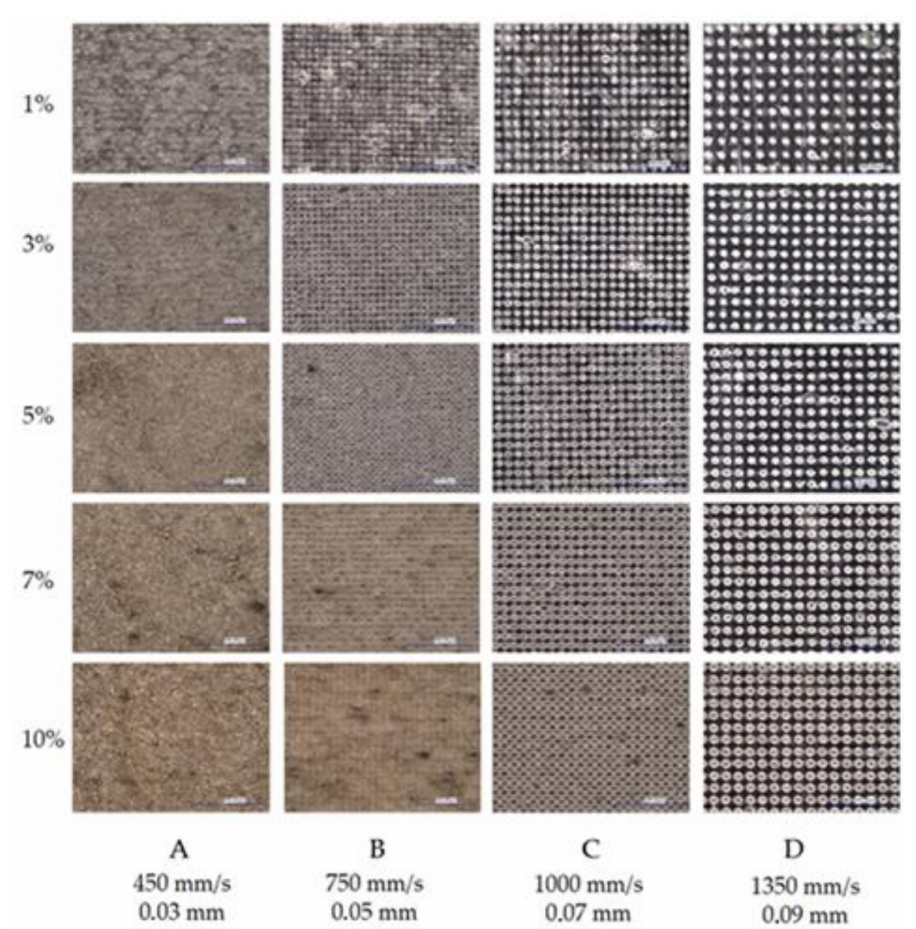
Figure 13. Microscopic photographs of graphic signs obtained with different parameters of the laser beam on specimens with different silica contents; magnification 200 × ; dimensions of investigated images 1000 µ m × 1500 µ m, (Keyence VHX-7000). ( A ) 450 mm/s, 0.03 mm, ( B ) 750 mm/s, 0.05 mm,